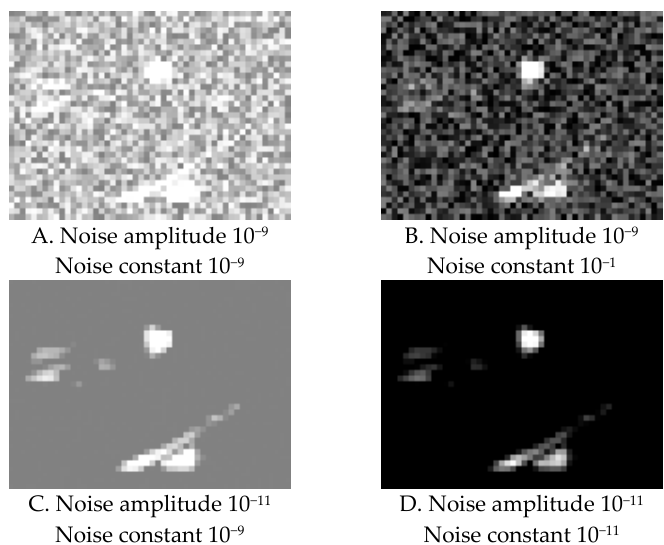
Figure 10. Examples of an effect of different noise parameters on the saliency map. Adding more noise only changes the saliency map, which is used as initial data, but does not modify the integration and firing process itself.